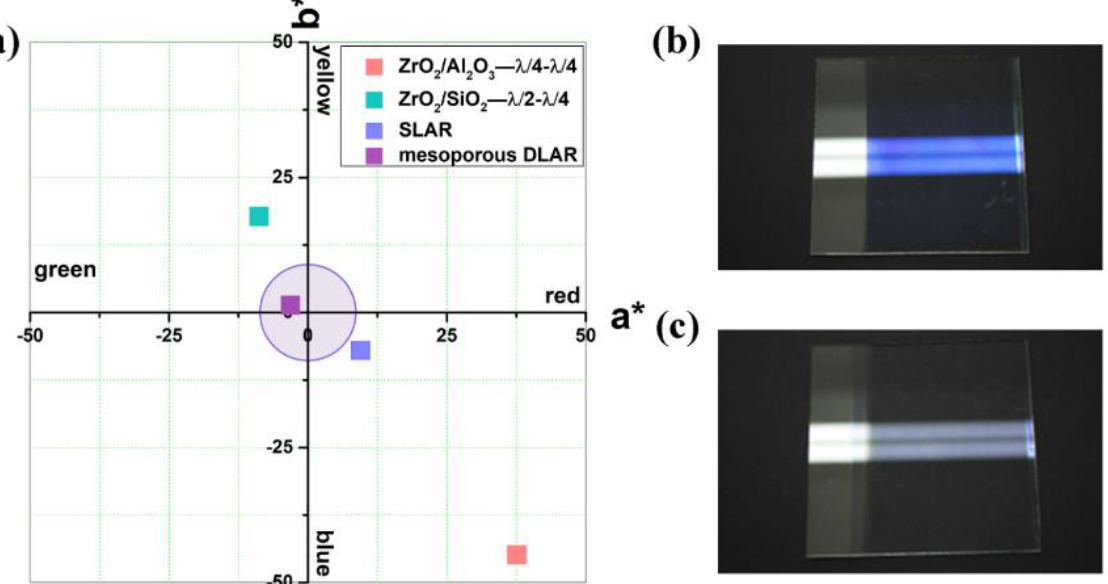
Figure 3. ( a ) Chromaticity points of different ARCs. a* and b* are coordinates derived from the reflectance spectrum to measure the chromaticity value. When the point falls inside the purple circle, the color is closer to neutrality. The color of the ( b ) SLARC and ( c ) mesoporous DLARC. Re- printed with permission [45]; 2020, Elsevier.